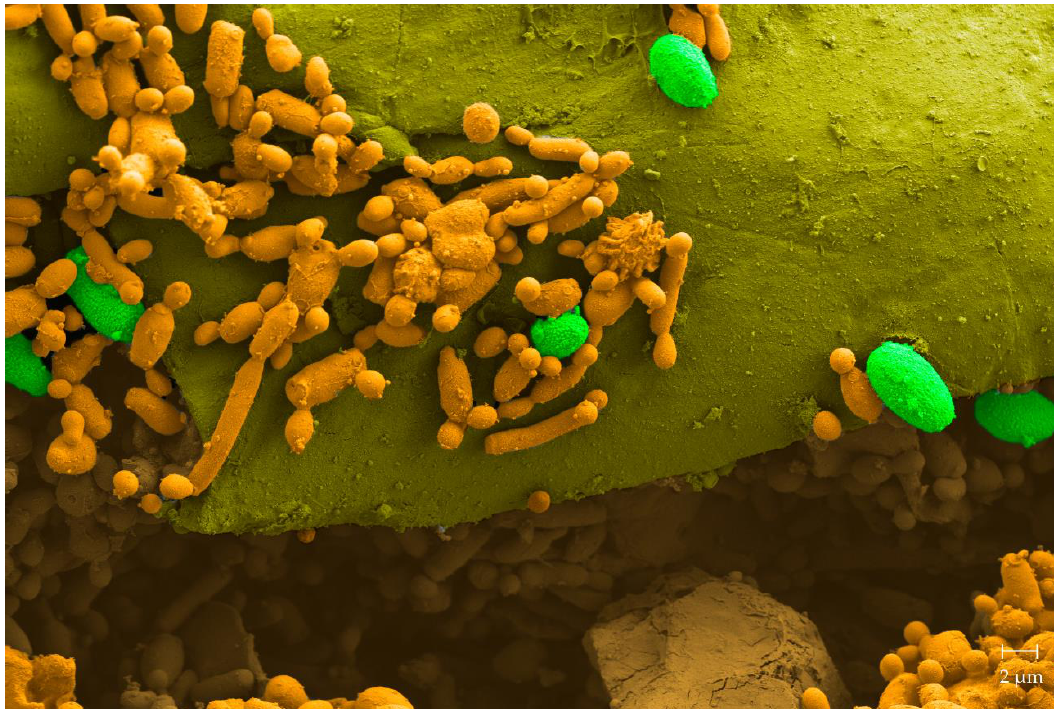
Figure 3. Colored scanning electron microscope (SEM) image of the surface of a lemon wound inoculated with the killer yeast C. lusitaniae 146. The image shows a cross section of a lemon wound where colonization by the killer yeast (orange) and ungerminated spores of citrus phypathogen P. digitatum (green) are observed.